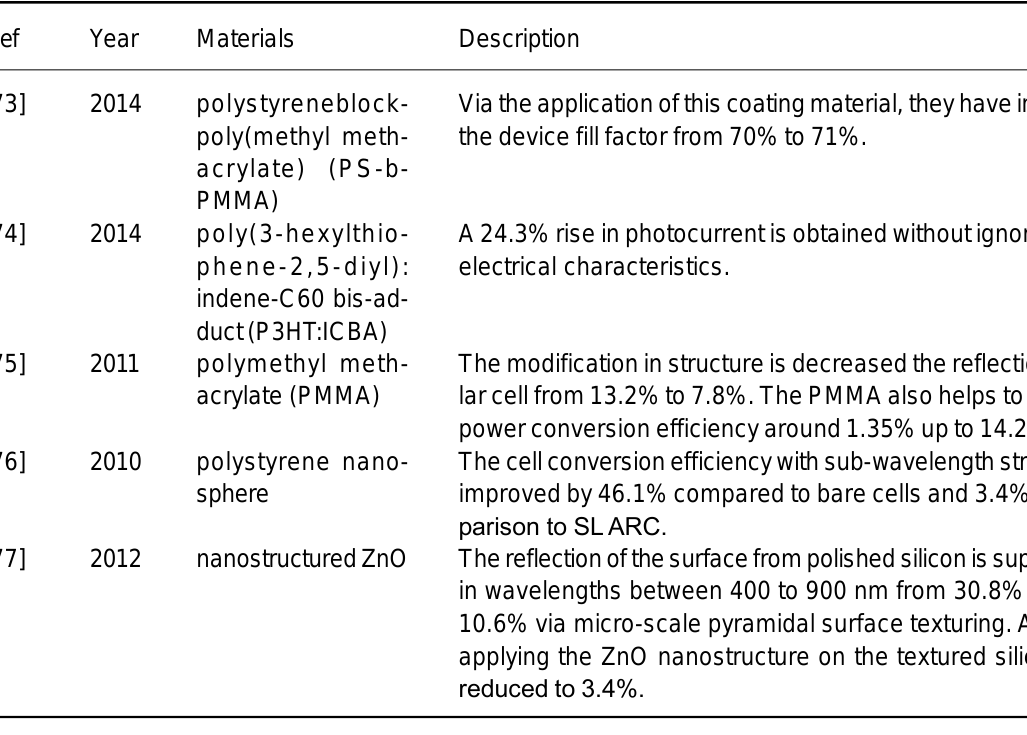
Table 4. A summary of biomimetic photonic nanostructures ARC